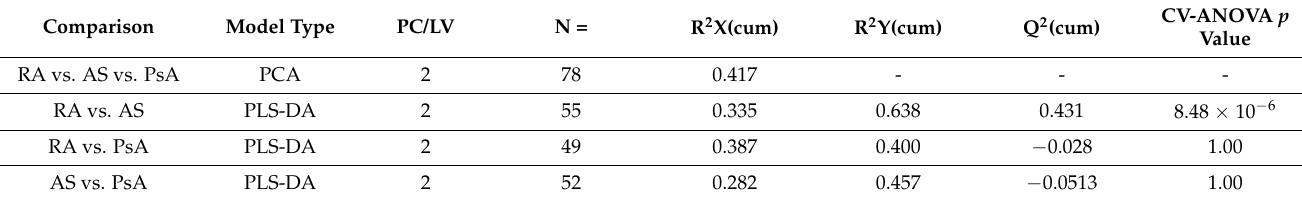
Table 4. The multivariate analysis models summary for RA, AS, PsA comparison.